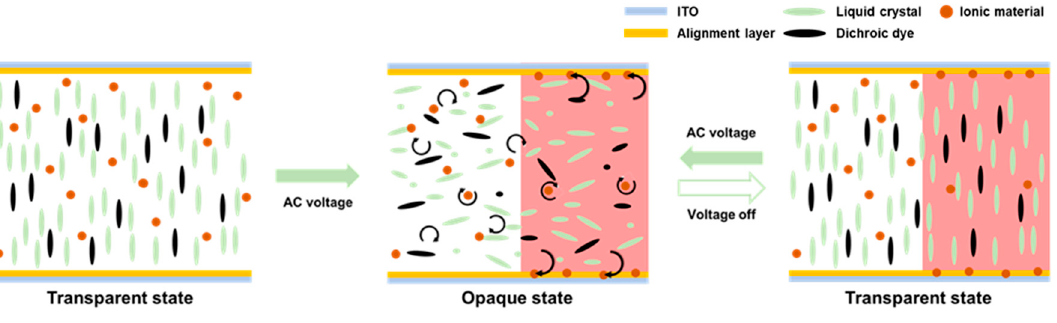
Figure 1. Structure and operation of the ion-doped LC cell.